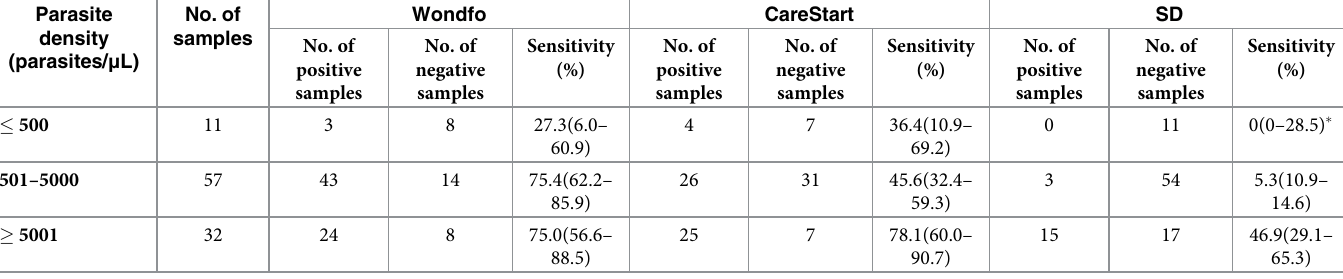
Table 4. Comparison of the sensitivity of the three RDTs in the detection of P . ovale categorized by parasite density. Parasite density